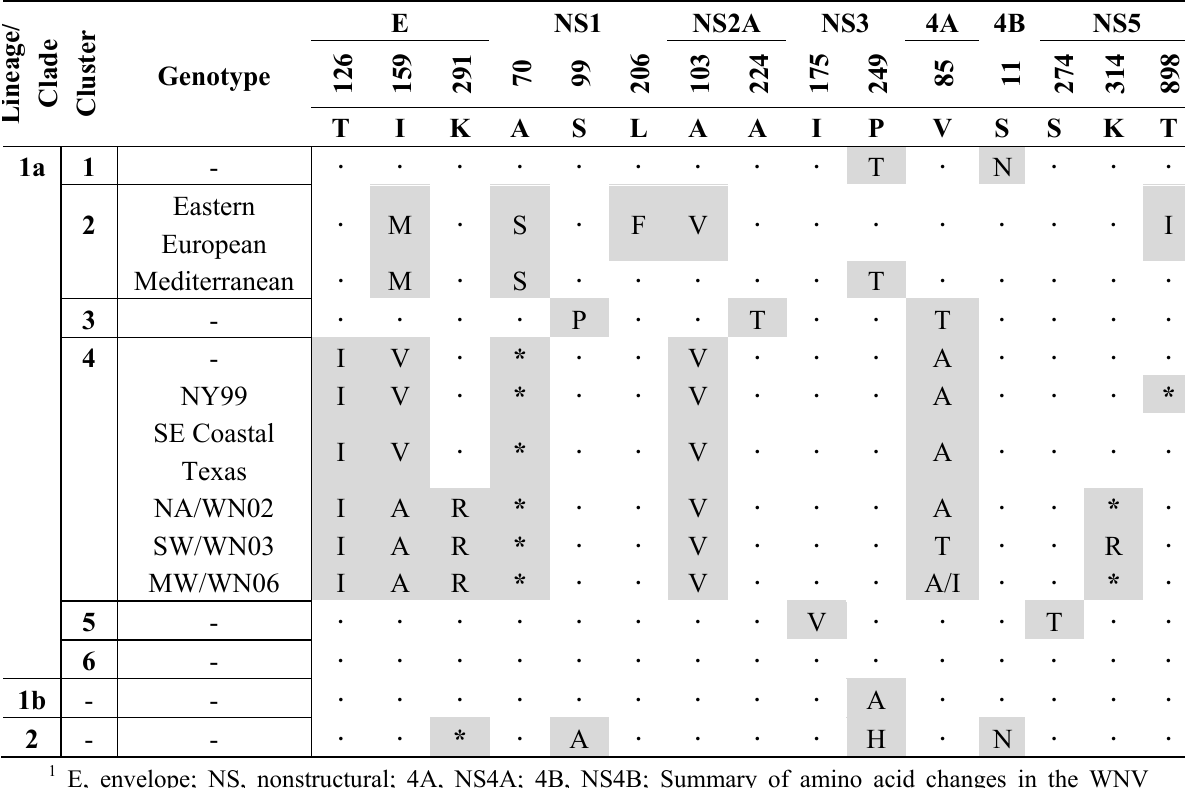
Table 1. Global evolution of WNV Lineage 1a: conserved amino acid substitutions 1 .